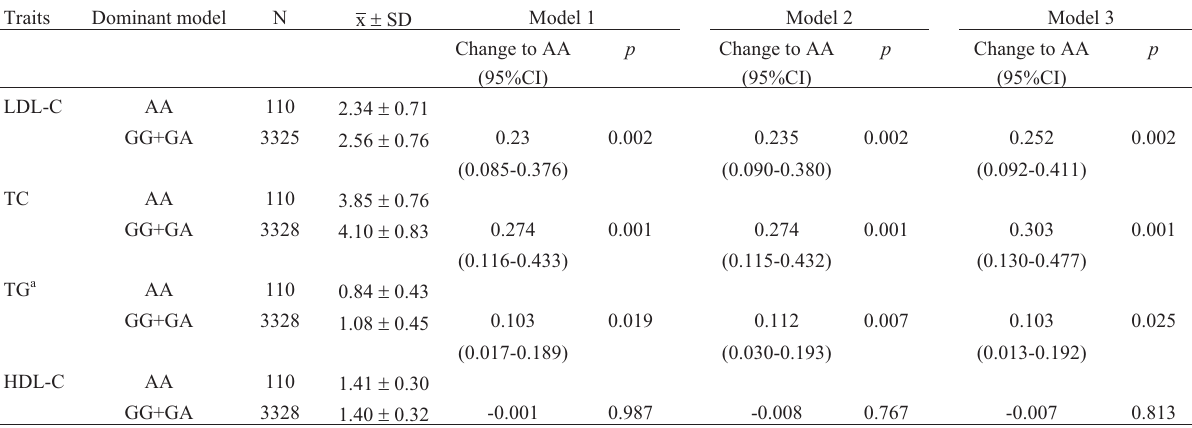
Table 2 - Difference in lipid levels with different genotypes of rs6499640.